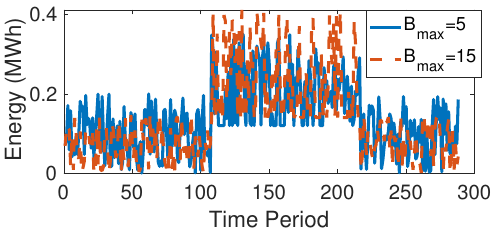
Figure 7. The total amount of Energy given back to the Utility as a function of time. The solid line represents the total amount of energy given back when B max = 5 kWh and the broken line represents the total amount of energy given back when B max = 15 kWh. Recall that each prosumer’s capacity is uniformly distributed between [ 0, B max ]